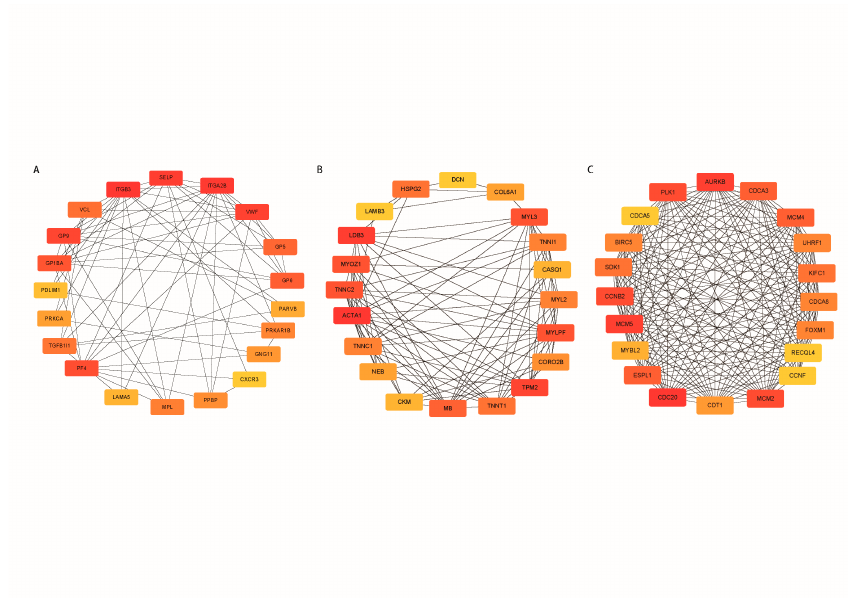
Figure 5. Visualization of potential genes in stage-specific modules. ( A ) PPI network for brown module. ( B ) PPI network for yellow module. ( C ) PPI network for blue module. Different colors indicate the level of genetic connectivity, with red indicating high connectivity and yellow indicating low